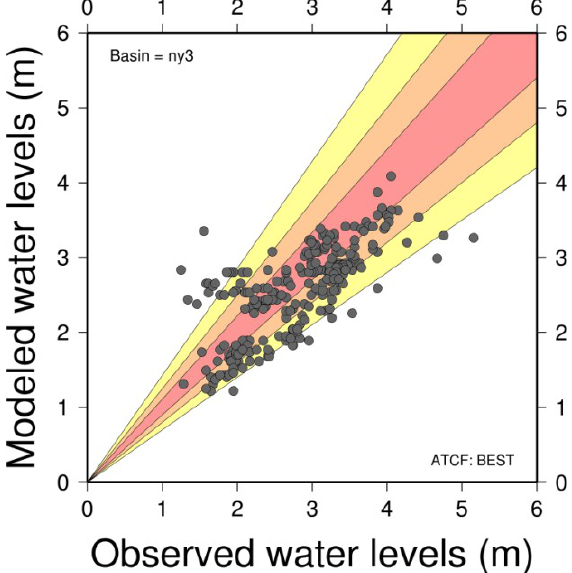
Figure 15. USGS High Water Marks (HWM) vs. SLOSH model-simulated surge-plus-tides maximum height of inundation (m) AGL. The dark orange cone depicts the 10% error, the orange cone depicts 20% error and the yellow cone depicts 30% error. The water surface elevation errors at most stations are within the 10%–20% range.